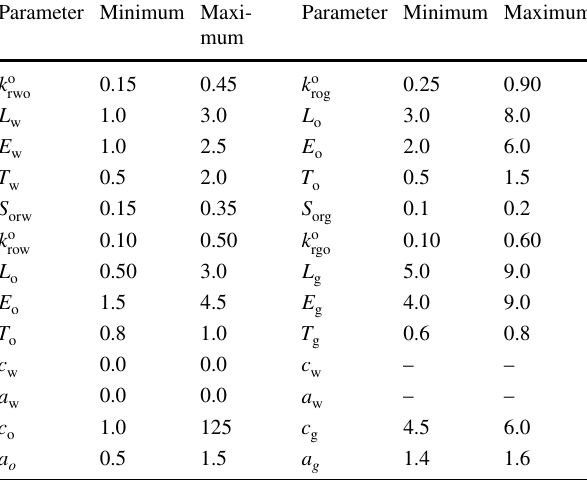
Table 4 Range of initial guesses for estimating unknown variable in the ACO algorithm for oil–water and gas–oil